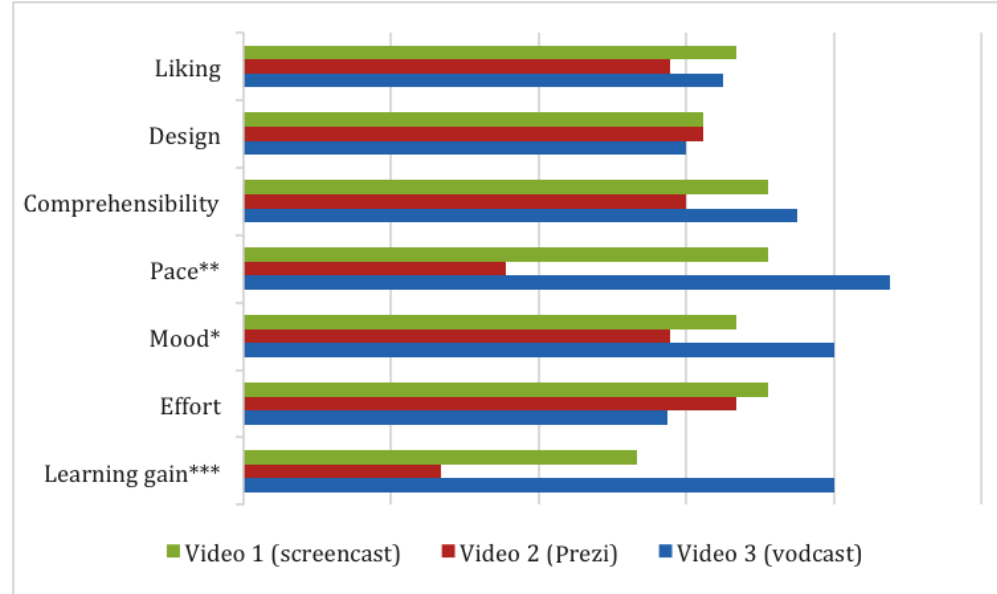
Figure 5. Ratings of learning experiences. Note, higher scores indicate a higher agreement to the item (i.e., for the matter of pace it is its appropriateness). * p < 0.05, ** p < 0.01, *** p <